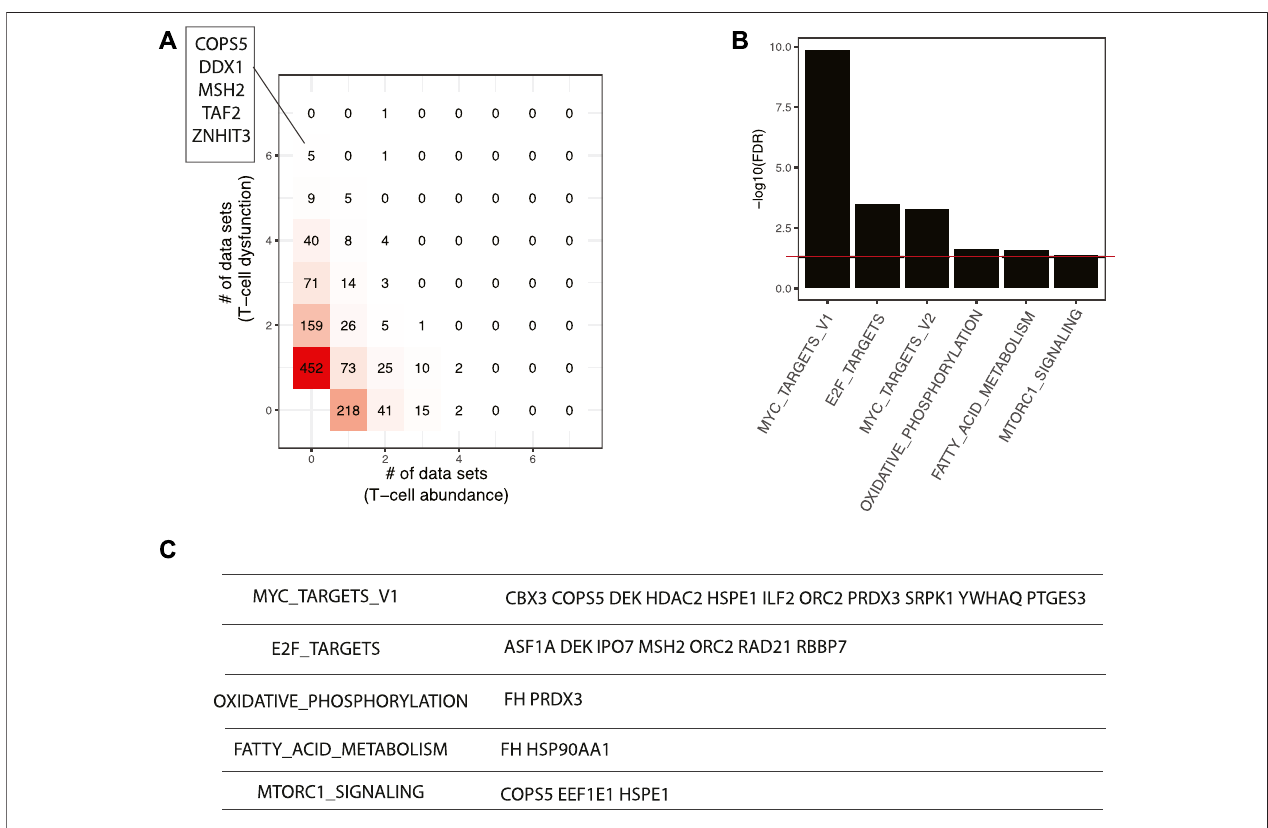
FIGURE 6 | Master regulators that are associated with poor responses in ICB-based immunotherapy. (A) Comparison of master regulators predicted from T cell in fi ltrationandTcelldysfunctionsignatures.Themasterregulatorspredicted inatleastsixdatasetswithTcelldysfunctionsignaturewereshown. (B) Pathwaysenriched in top-ranking master regulators. (C) Selected master regulators grouped by enriched